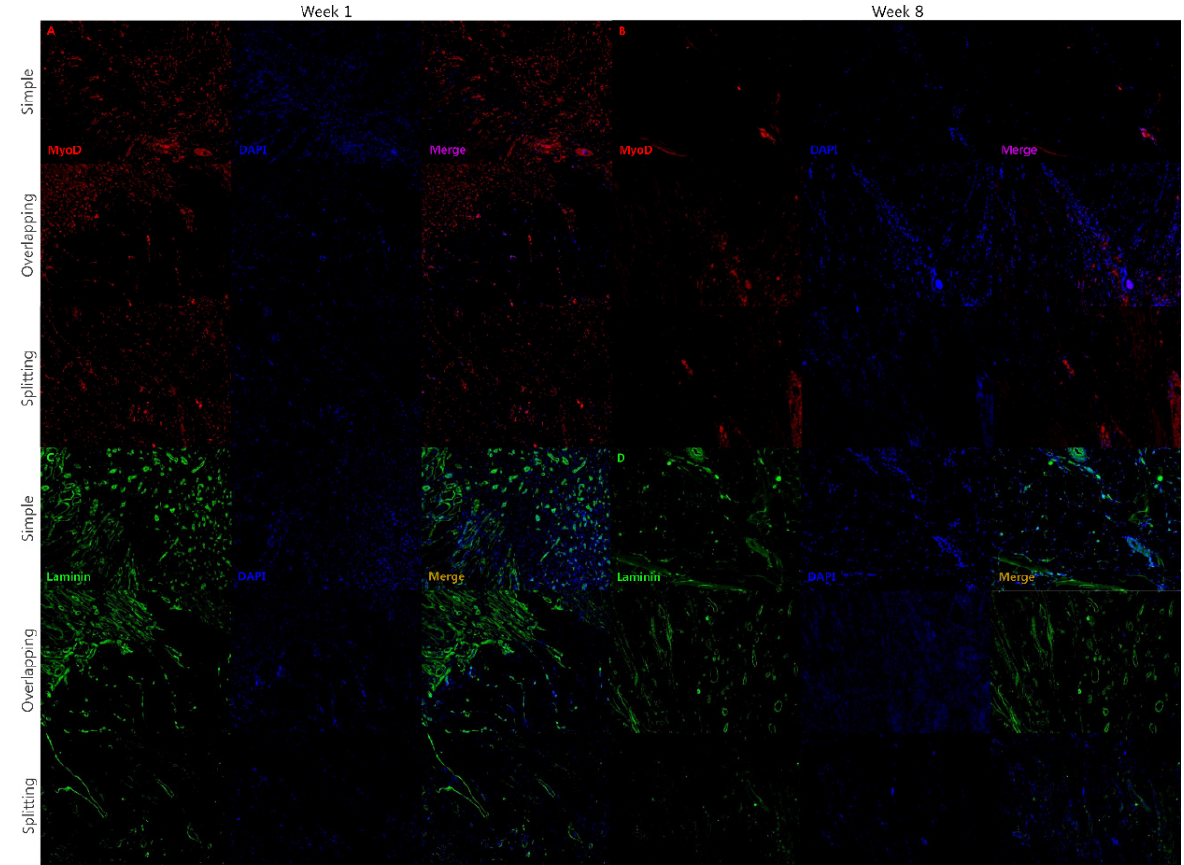
Figure 10. Immunofluorescence for MyoD and laminin. ( A ) Muscle regeneration was strongly activated, as evidenced by strong expression of MyoD, in all groups at week 1. ( B ) The simple interrupted suture group exhibited lower muscle regeneration activity and MyoD expression than the overlapping and splitting suture groups, in which the expression of MyoD was maintained at week 8. ( C ) The simple interrupted suture and overlapping suture groups exhibited organized muscle remodeling with strong expression of laminin at weeks 1 and 8. ( D ) In contrast, the splitting suture group showed weak expression of laminin, indicating unorganized and scarce muscle remodeling, until week 8.